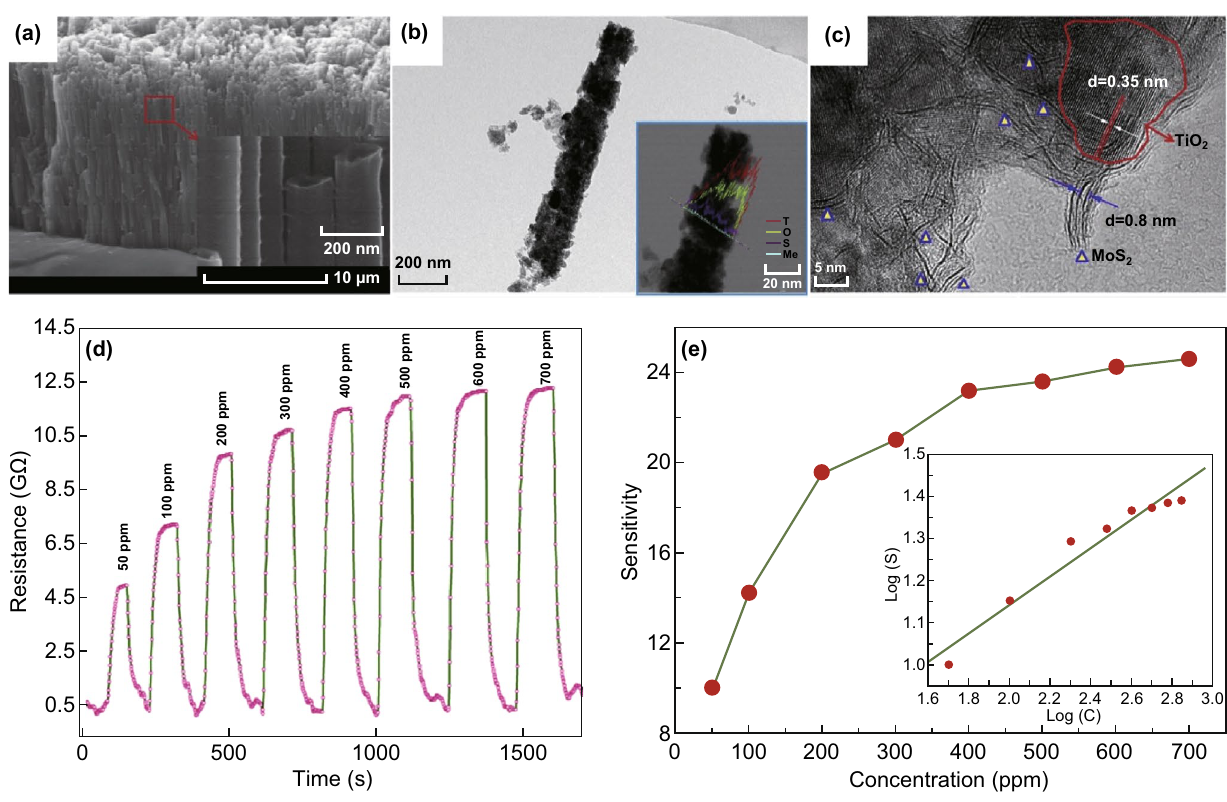
Fig. 6 a SEM image of the TiO 2 nanotubes, and the inset showing the opening top of the tubes, b, c HRTEM images of the MoS 2 –TiO 2 com- posites, and the elemental distribution in the inset of b , d the response and recovery curves of the MoS 2 –TiO 2 sensor to various ethanol concen- trations from 50 to 700 ppm at 150 °C. e Sensitivity of the MoS 2 –TiO 2 sensor at different concentrations of ethanol. Adapted with permission from Ref. [207]. Copyright 2016